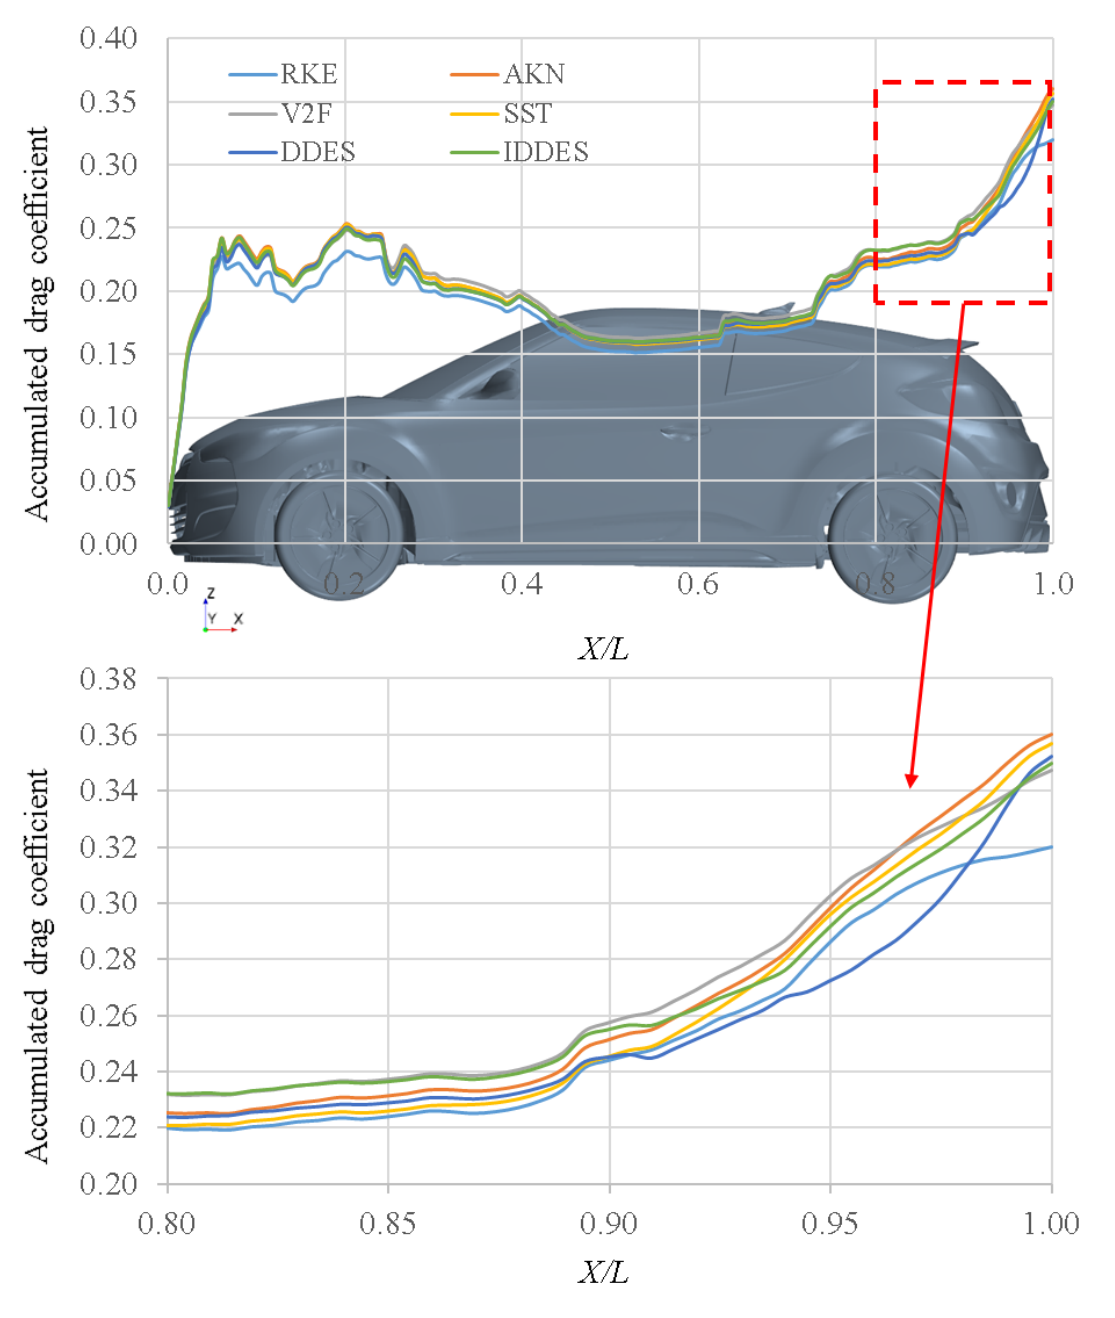
Figure 10. Accumulated drag coefficient along the streamwise direction for the baseline case obtained from all turbulence models ( L represents the vehicle total